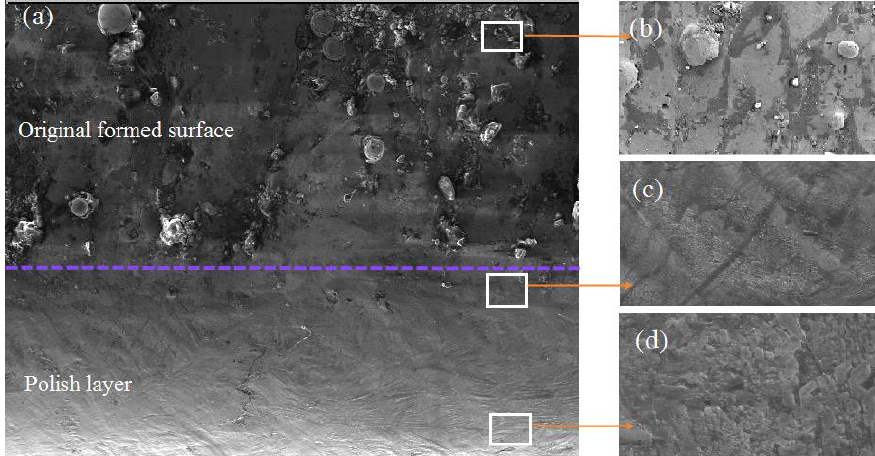
Figure 15. SEM images of the original formed surface and the polished layer. ( a ) Total of the original formed surface and the polished layer, ( b ) original formed surface, ( c ) melt zone and heat-affected zone, and ( d ) polished layer crystal.